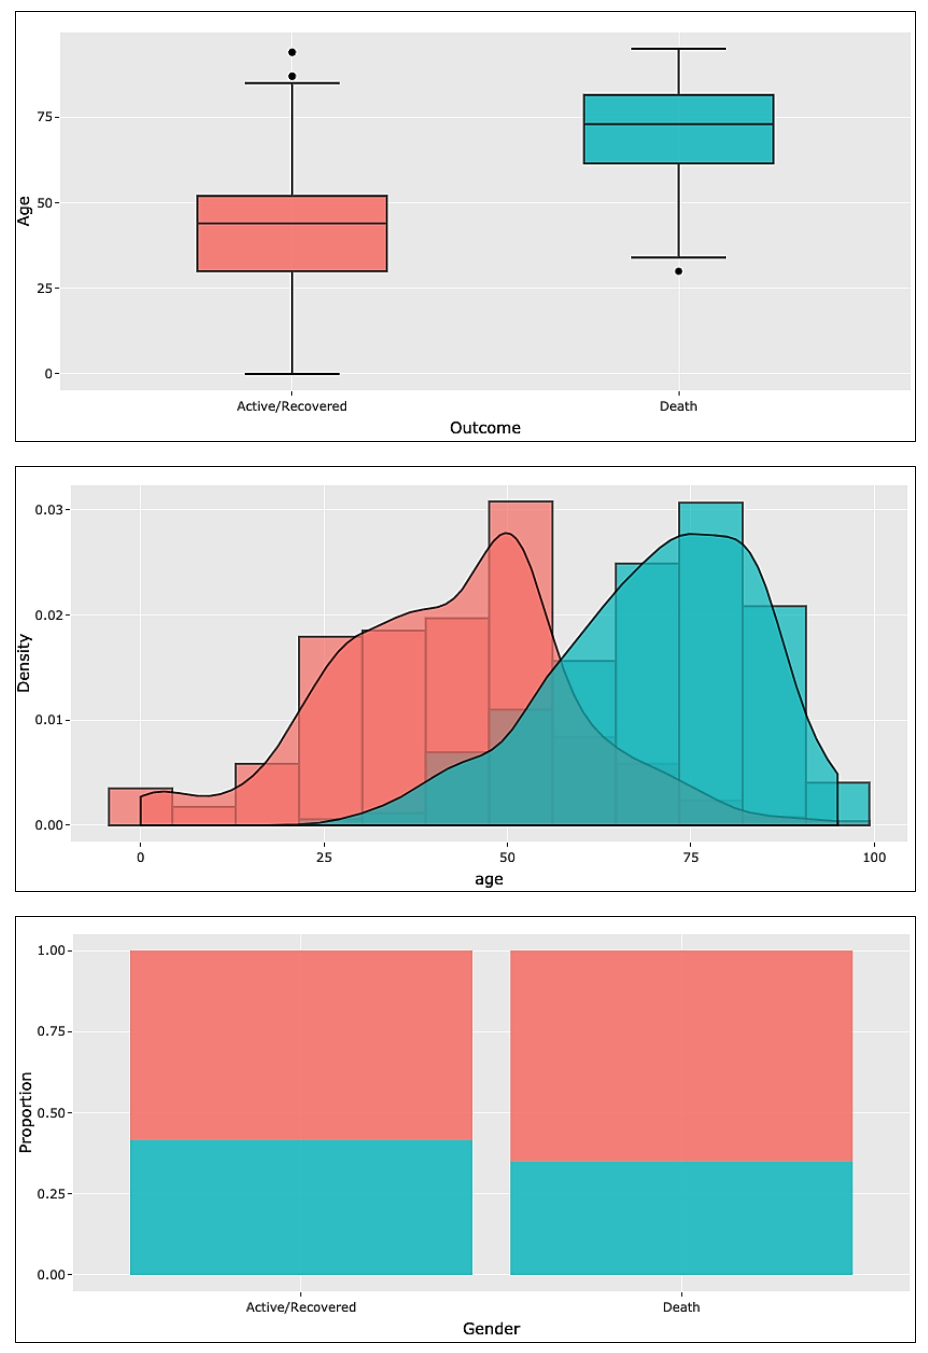
Figure 16. Summary Visualizations of Demographics Characteristics of COVID-19